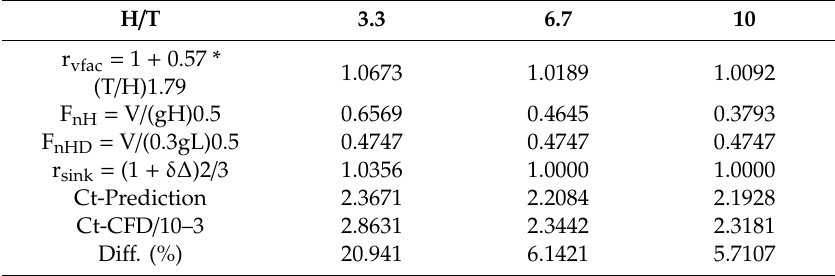
Table 17. The difference of total resistance coefficients between Raven’s method and CFD results.